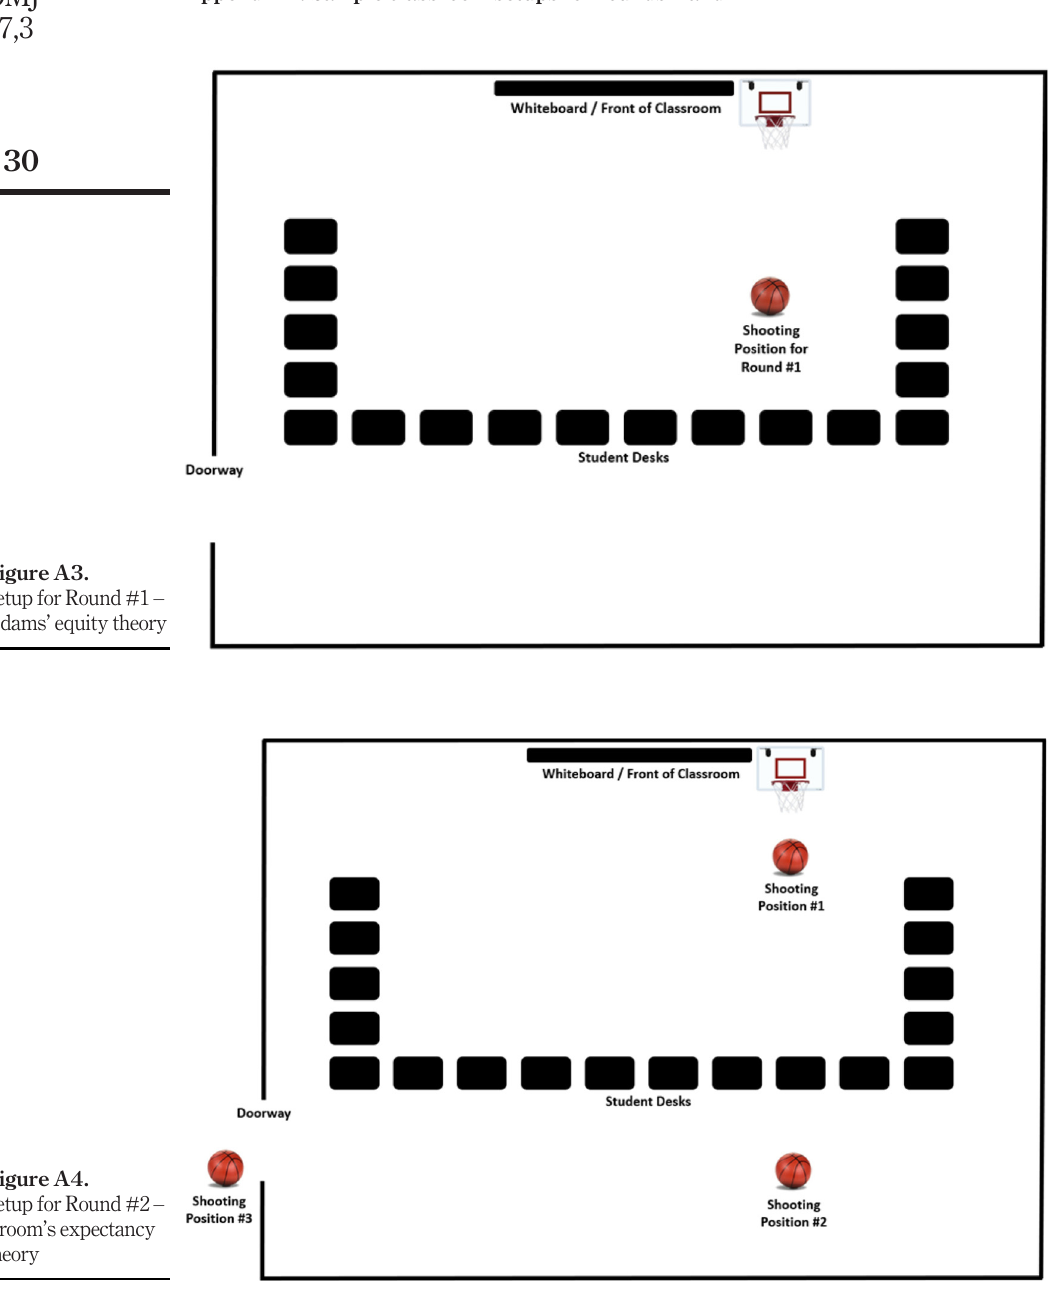
Figure A4. Setup for Round #2 –